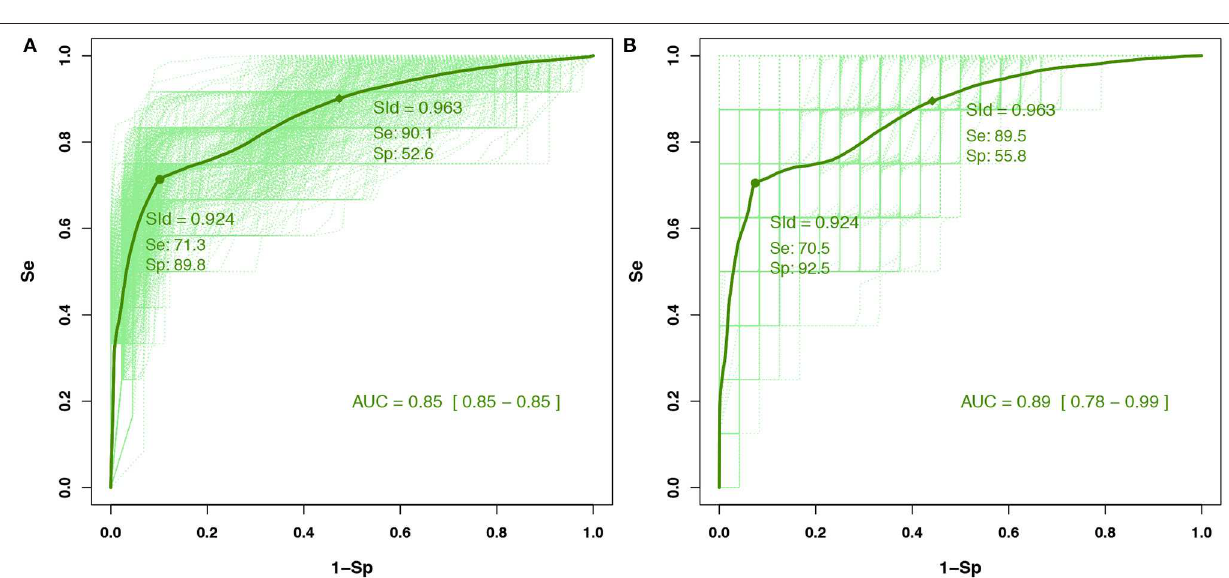
FIGURE 4 | Receiver operating characteristic (ROC) curves for (A) the training cohort involving 15 people with pMS and (B) the test cohort involving seven people with pMS for the IGTD detection method. Cutoffs were determined with the training cohort, and their predictive values were computed within the test cohort. Dashed curves are ROC curves for each configuration of the Monte Carlo cross-validation (and the nested four-fold cross-validation for the training set). Plain curves are the means of all dashed